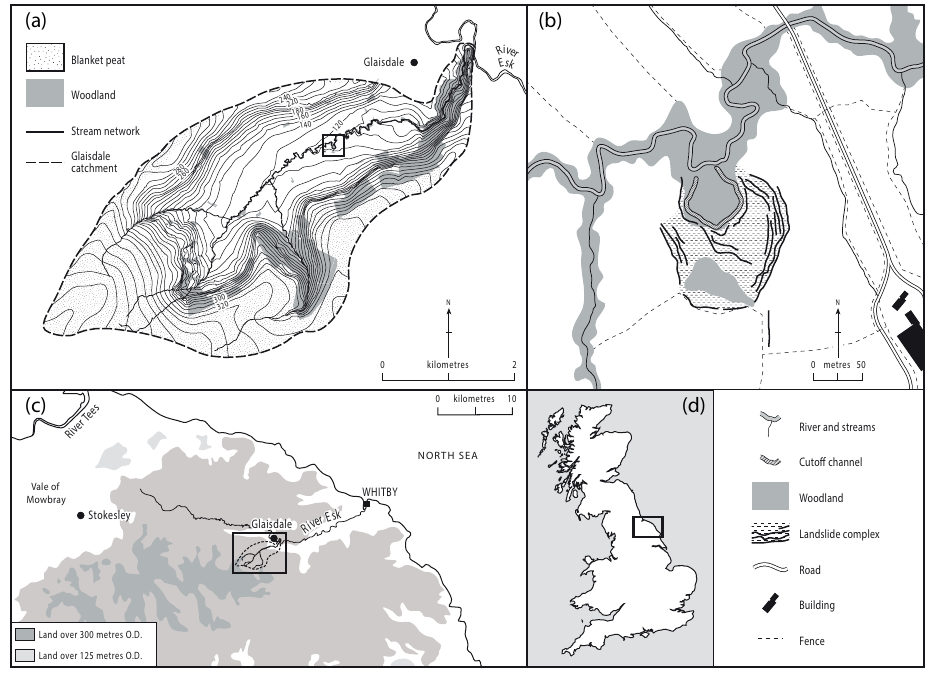
Figure 1. Maps illustrating (a) Glaisdale catchment and associated land units. Contours are displayed at 10m intervals. The box identifies the reach of Glaisdale Beck experiencing extensive landslide inputs, which was subsequently diverted. This is shown in detail in (b) . The location of Glaisdale Beck in the regional and national context is provided in (c) and (d) respectively. © Crown Copyright/database right 2015. An Ordnance Survey/EDINA supplied service.